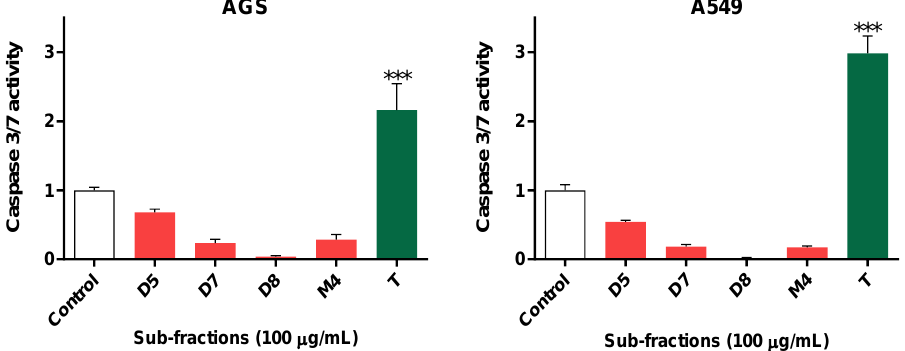
Figure 3. Effect of the sub-fractions (100 µg/mL) on the activity of caspase-3/7 of AGS and A549 cells after 24 h of exposure. Topotecan, T (0.5 µM) was used as a positive control. Data represent the means ± SD of at least three independent experiments performed in triplicate. *** p < 0.001.